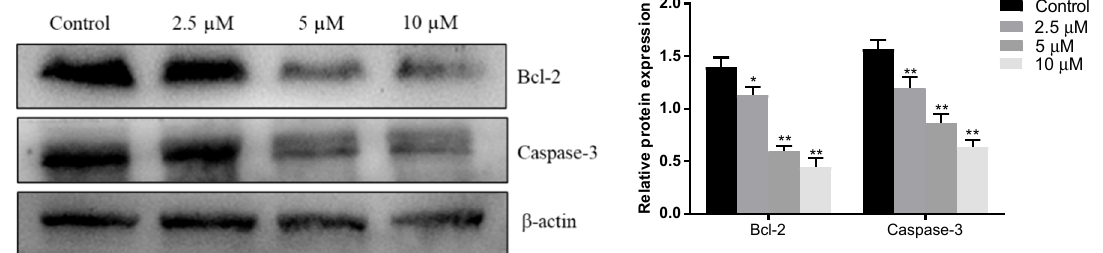
Figure 3. The impact of compound 2 on the expression level of Bcl-2 and caspase-3 in HepG2 cells. Each experiment was performed thricely in an independent manner and the obtained results are given as mean ± SEM. * p < 0.05, ** p -value < 0.01 compared to the control.